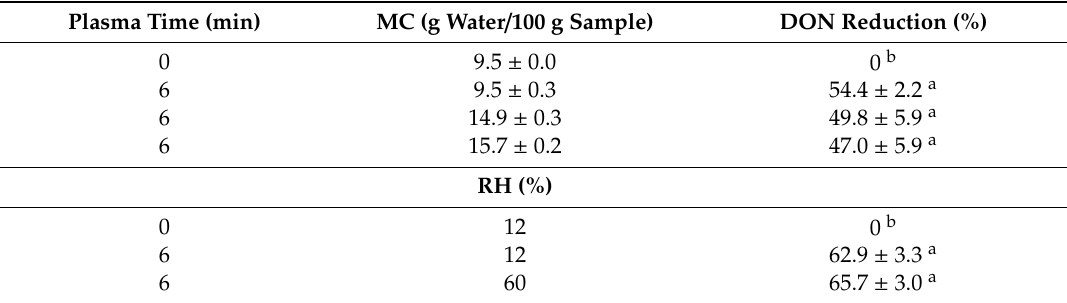
Table 3. E ff ect of moisture content (MC) of barley and relative humidity (RH) of the surrounding air on deoxynivalenol (DON) degradation by